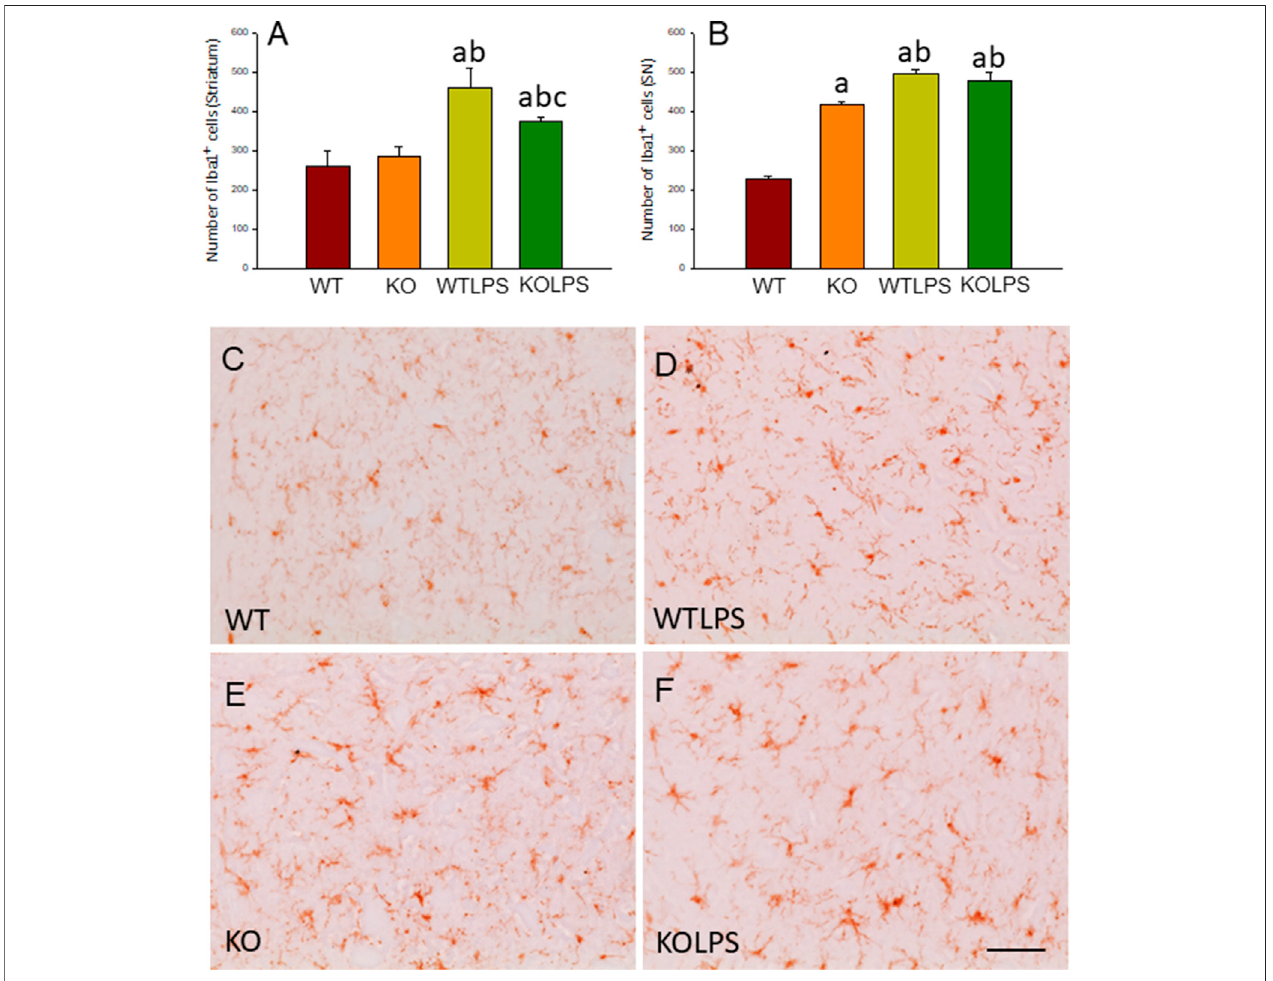
FIGURE 3 | Evaluation of the microglial activation induced by LPS treatment in WT and Gal3KO mice. The effect of LPS was evaluated in striatum (A) and SN (B) from WT and Gal3KO mice. Results are mean ± SD of at least three mice per experimental group, expressed as the number of Iba1 + cells per mm 2 . Statistical analysis: One-way ANOVA followed by the Fisher ’ s LSD post hoc test for multiple comparisons was used, with α (cid:2) 0.05: (a) , compared with WT group; (b) , compared with KO group; (c) , compared with the WTLPS group; p < 0.001 (C – F) Representative immunostaining from striatum sections of the different experimental groups.